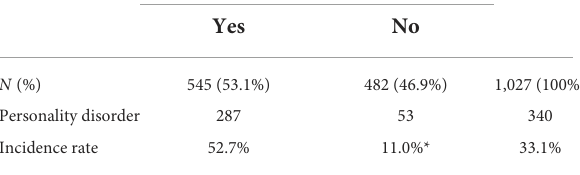
TABLE 3 The incidence rate of personality disorders after frontal and/or temporal lobe injury. Frontal and/or temporal lobe damage Total